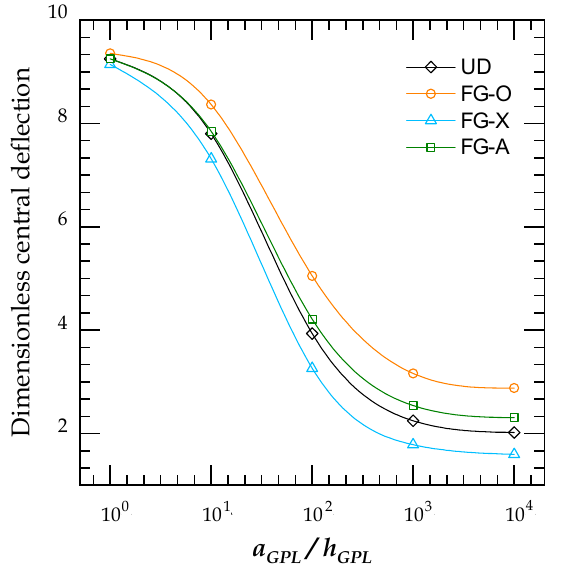
25 of 40 Figure 10. Effect of nonlocal and small-scale parameters on the dimensionless central deflection of